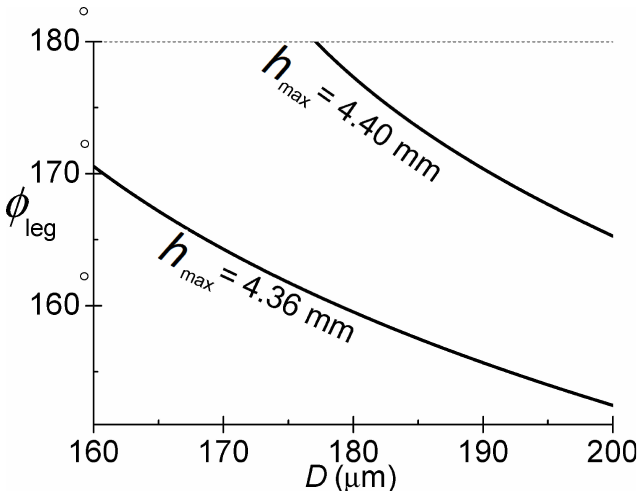
= 4 . 38 ± 0 . 02 mm; from max